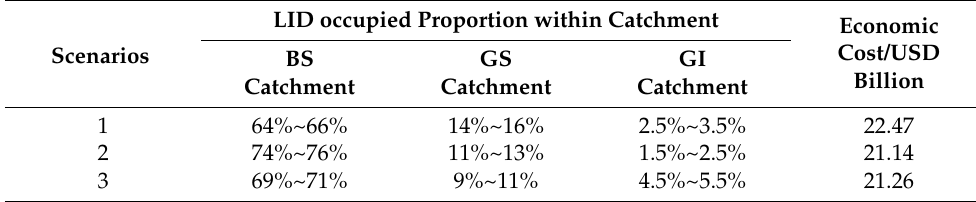
Table 2. LID occupied proportion within the catchment and economic cost of three scenarios.